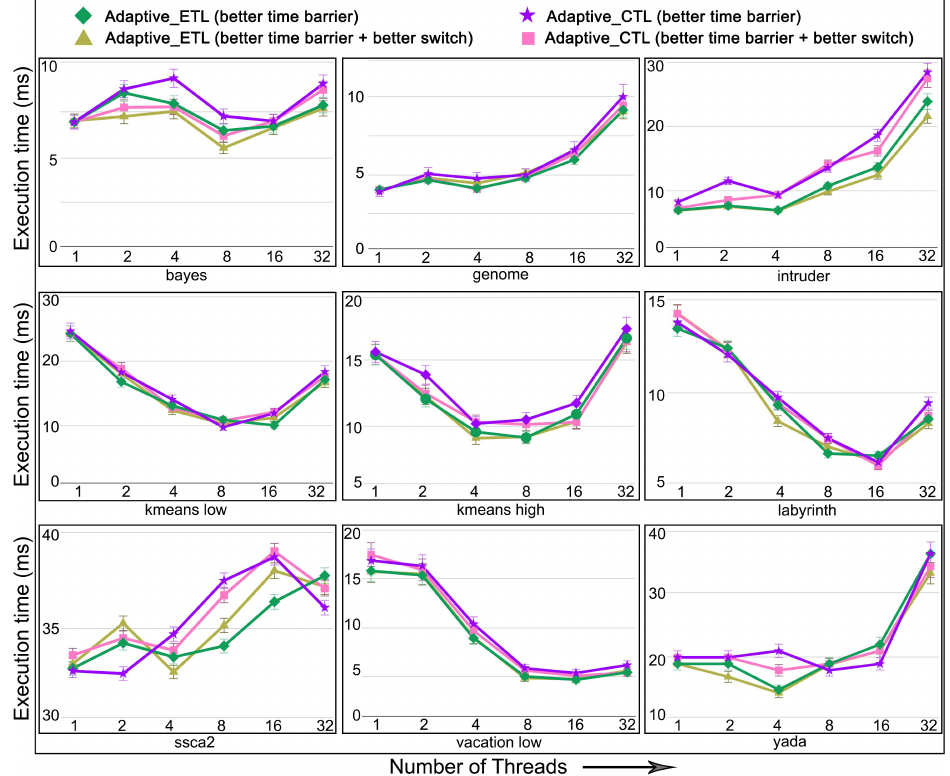
Figure 25. Execution time in STAMP benchmarks using better barrier and better switch in non- persistent